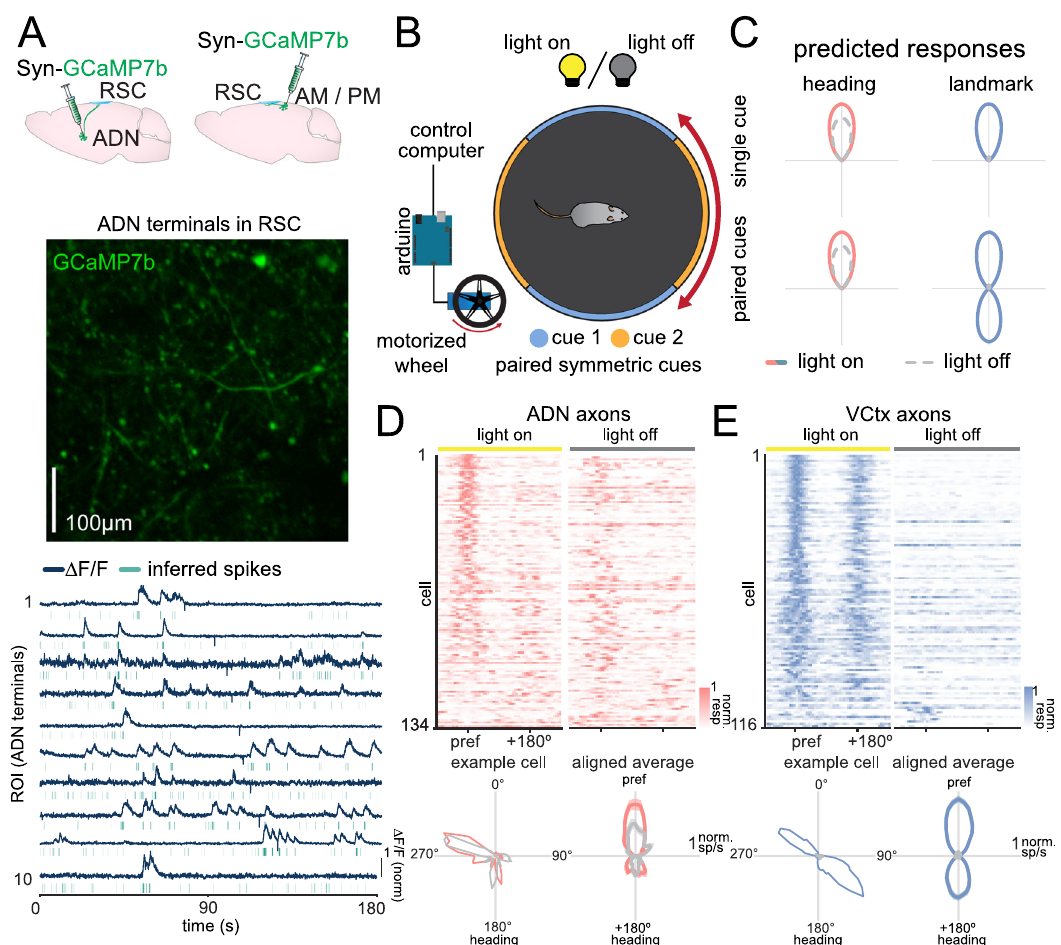
Fig.4|ImagingprojectionsfromADNandvisualcortexrevealdistinctlytuned responses sent to RSC. A Top: Example of injection sites in separate cohorts of mice. AAV-Syn-GCaMP7b was injected into either ADN or AM/PM of WT mice. Middle: Example imaging fi eld in RSC of axon terminals originating from ADN ( n =17imaging fi eldsover4mice).Bottom:Example Δ F / F tracesandinferredspikes forimagedADNterminalsitRSC. B Exampleschematicofexperimentalconditions. The single white cue card has been replaced with paired symmetric cues on the fl oating chamber, which is driven by a motorized wheel. Neurons from RSC are recorded across light-on and light-off phases. C Schematic of expected axonal responses. Left: Axons terminals encoding heading independent of visual cues are expected to have unimodal tuning curves across both conditions that are not